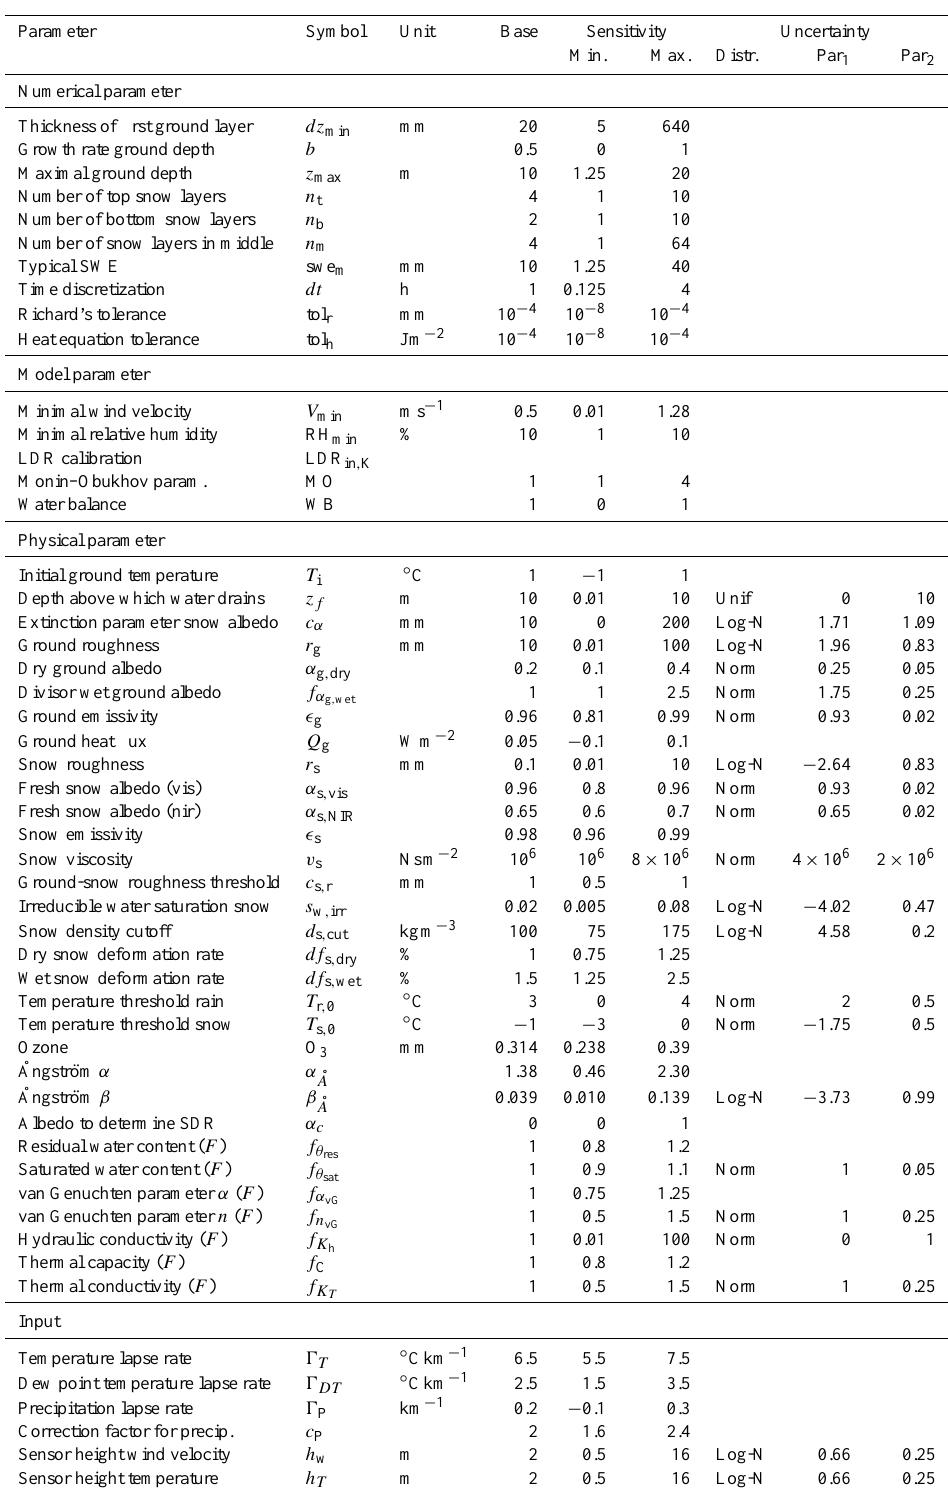
Table 3. Parameters selected for the sensitivity study. The minimum and the maximum indicate the range from which the parameters are sampled, and base indicates the standard choice used in, e.g., local sensitivity studies. The columns below ”Uncertainty” indicate the proper- ties of the prior distributions of the parameters considered in the uncertainty analysis. The values of the two LDR parameters (Konzelmann et al., 1994) change between 0.484 and 0.43, and 5.7 and 8 (Gubler et al.,